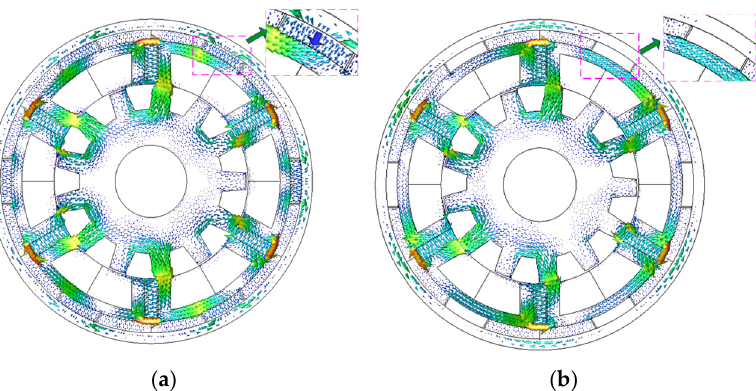
Figure 2. Illustration of on-load UD effect: open-circuit field distributions ( a ) before or ( b ) after the q -axis current excitation ( I q = 14.14 A).